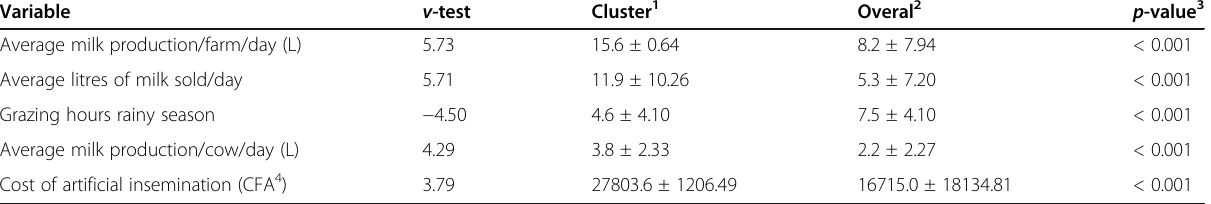
Table 6 Top 5 relevant quantitative variables that best describe the 28 farms from cluster 3. Overall sample n = 100 farms Variable